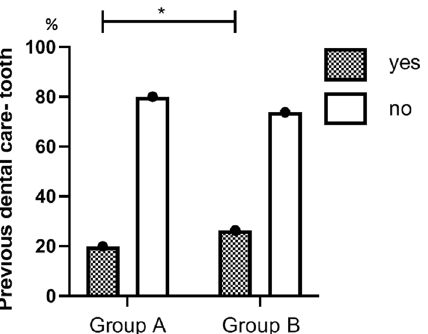
Figure 2. Previous dental care of the infected tooth, among patients hospitalized before and after (group A and B, respectively) inclusion of pediatric dental care in Israel’s National Health Insurance Law. The bars show the percentages of patients who received dental care prior to hospitalization, for the tooth that was the source of the infection. The difference between the groups in the percentage of those who received treatment is statistically significant. *p-value < 0.05.